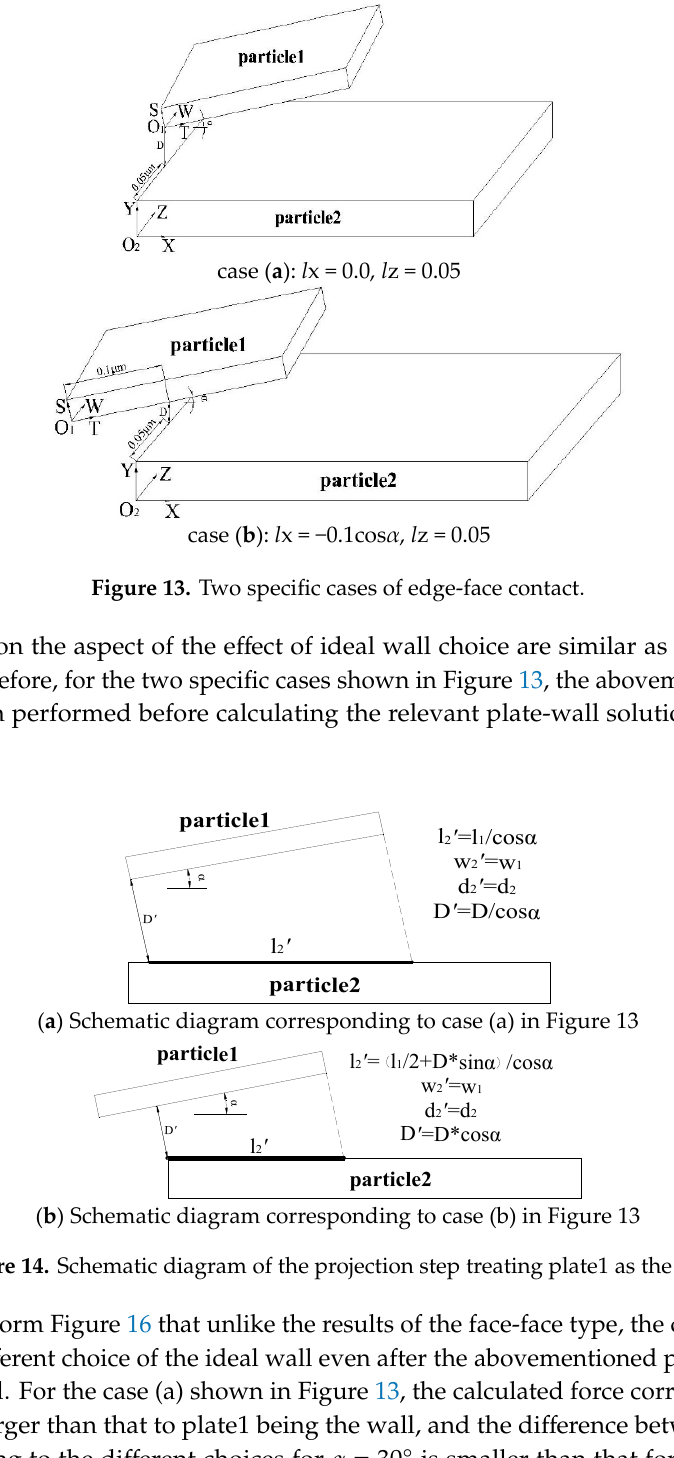
( a ) Schematic diagram corresponding to case (a) in Figure 13